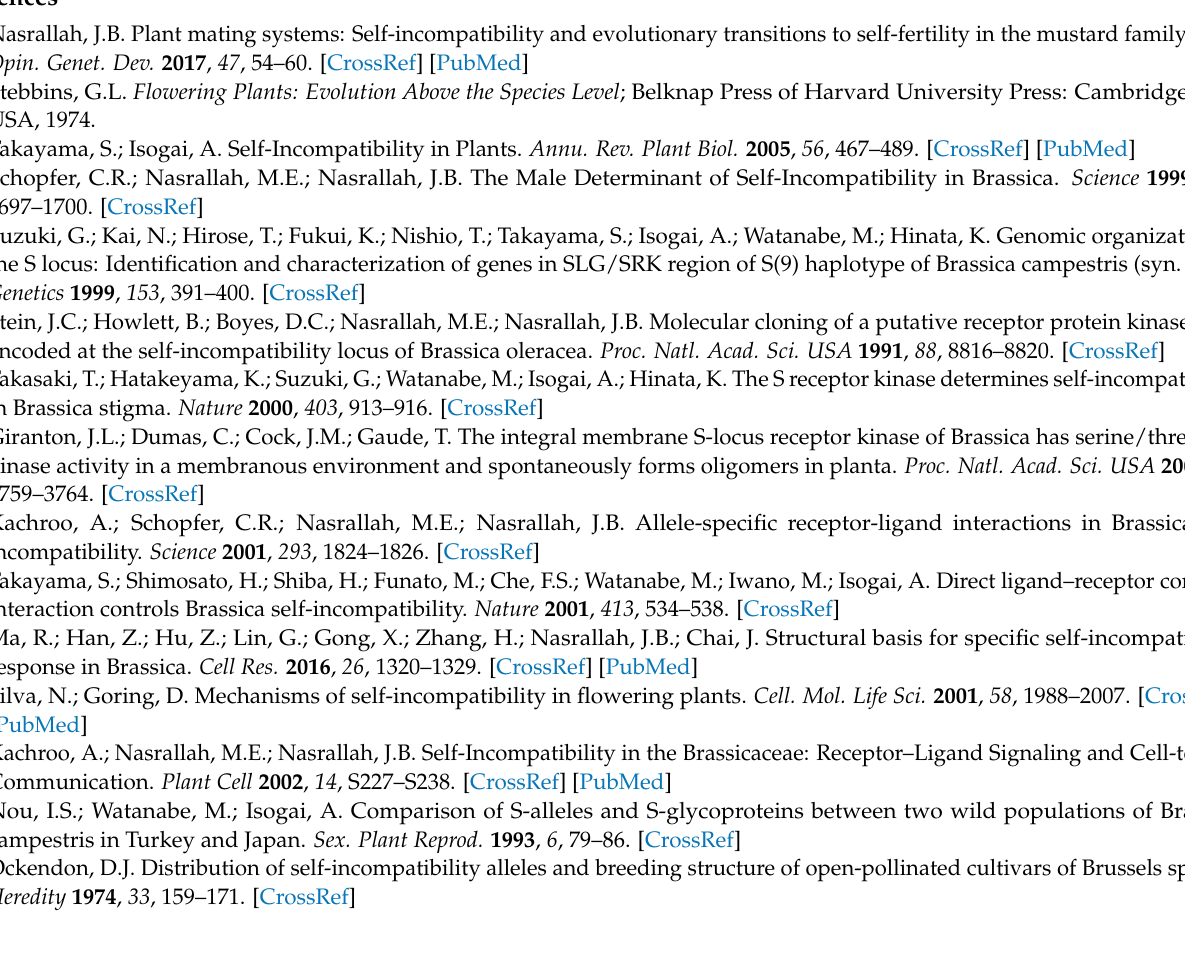
BnS-6 and BnS-7 ; Figure S2: PCR fragments amplified from ‘S-1300’ and 14 B. napus SC lines using SCAR markers; Figure S3: Expression analysis of SCR and SRK in the flower tissues of B. rapa and B. oleracea ; Figure S4: cis -elements prediction in the promoters of BnSCR-6 and BnSCR-1300 ; Table S1: Primers used in this study; Table S2: The result of PCR amplification with SCAR marker in the B. napus cultivars and inbred lines; Table S3: Pollination test results of T 2 generation transgenic plant with B. oleracea